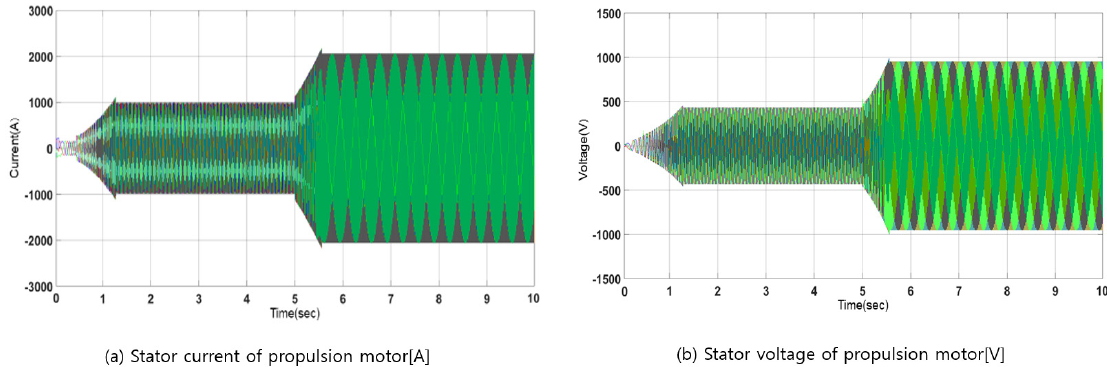
Figure 27. Simulation results of propulsion motor when load varies as 25 → 75%.